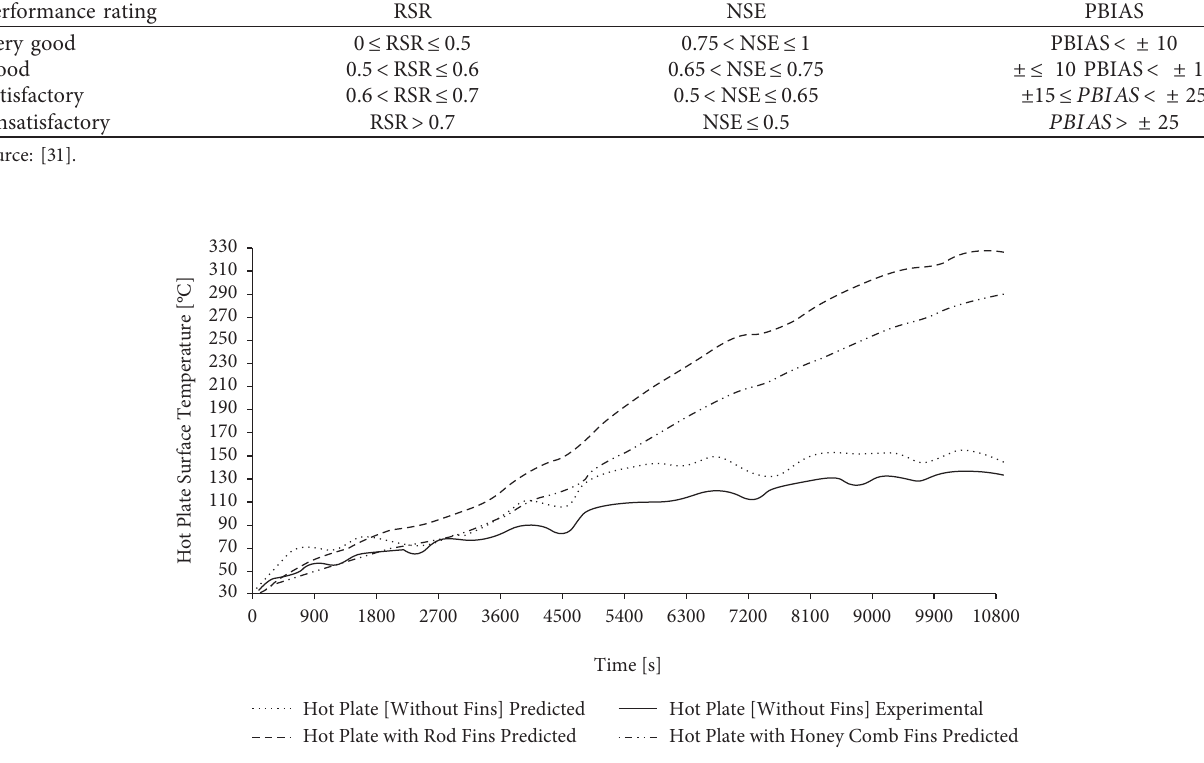
Figure 6: Hot plate surface temperature for the experimental and predicted conditions at different fin configurations. Table 7: Hot plate surface temperature for the experimental and predicted conditions at different fin configurations versus